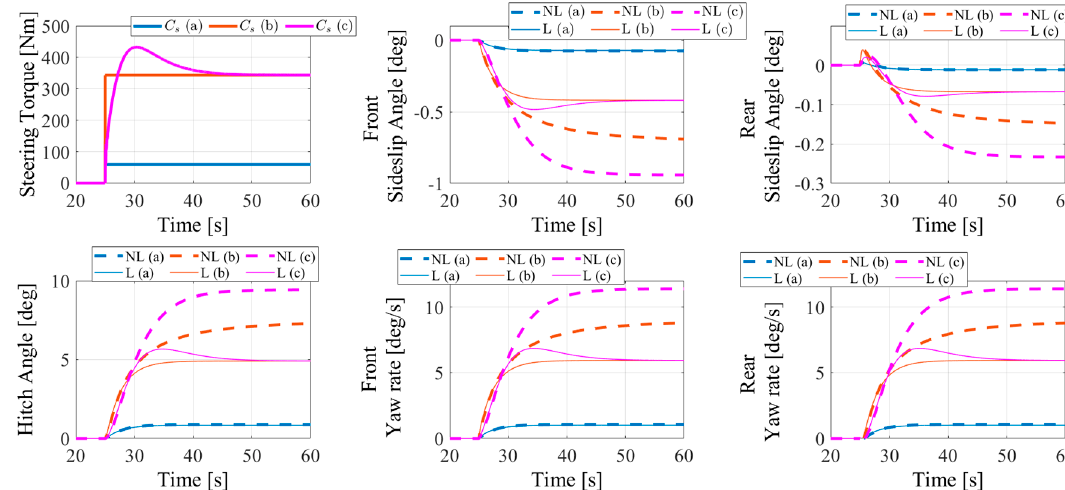
Figure 10. Non-linear (NL) and Linear (L) models response in terms of front ( β 1 ) and rear ( β 2 ) sideslip angles, hitch angle ( 𝛼 ), front ( 𝜓(cid:4662) (cid:2869) ) and rear ( 𝜓(cid:4662) (cid:2870) ) yaw rates for three steering input torques 𝐶 (cid:3046) at a constant longitudinal speed 𝑢1 = 20 km/h.